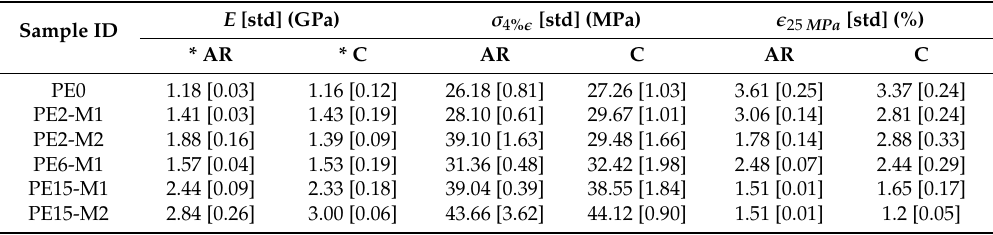
* AR = as-received, C = conditioned (at T = 40 ◦ C and RH =